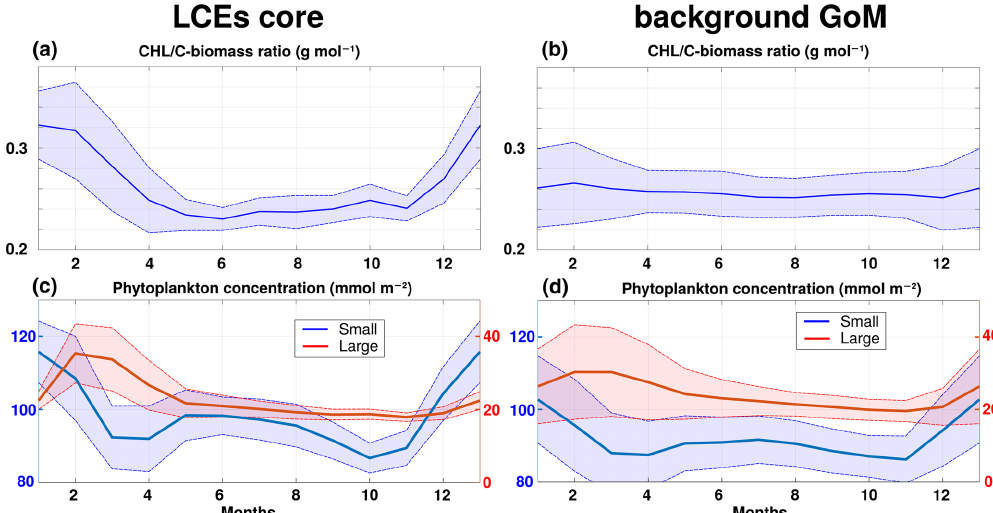
Figure A1. Climatological seasonal cycles of (a, b) the [ Chl ] / C-biomass ratio and (c, d) the vertically integrated content of phytoplankton concentration (small size in blue, large size in red). Panels (a, c) refer to the time series in the LCE core ( r < 50km), whereas (b, d) refer to the time series in the background GoM ( r > 200km). For each average cycle, the average value is shown (full line) along with its variability ( ± 1 standard deviation relative to the mean, dashed